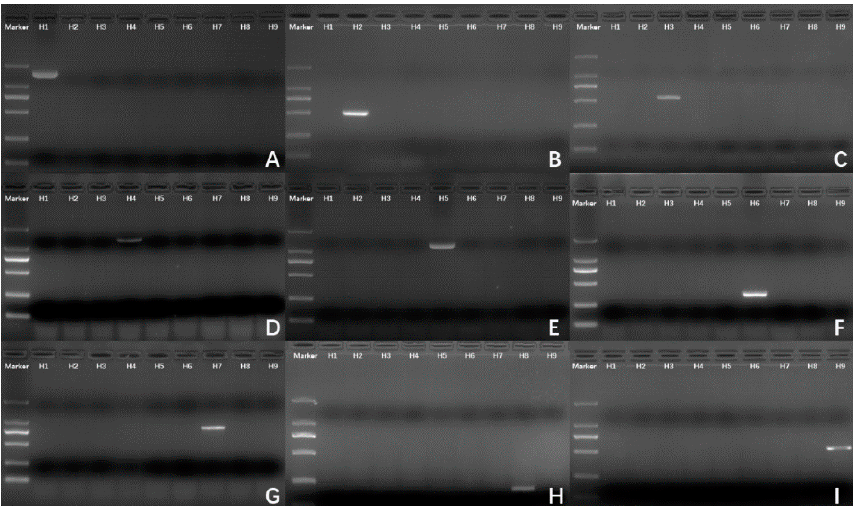
Figure 4. Agarose gel electrophoresis images of PCR experiment. ( A – I ) Using H1–H9-specific primers for H1–H9 cDNA (lanes marked as labelled). The marker used to the left side of each gel is a DNA ladder with the bands of 100, 250, 500, 750, 1000, and 2000 bp; the sample lanes are labelled from H1 to H9 in each gel. The original figures can be found in the Supplementary Materials.